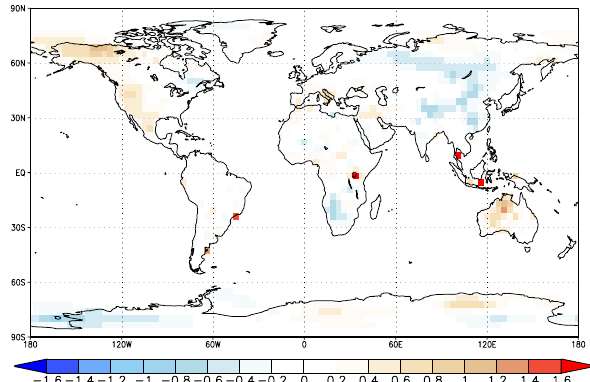
Fig. A2. Anomaly of SAT in ◦ C between a sensitivity study that is forced with a smoothed PI vegetation, and the PI control run of experiment 1 with a PI vegetation that has not been subjected to smoothing. Shown is the annual mean retrieved from a 30-yr clima- tology. The global average SAT anomaly is 0.02 ◦